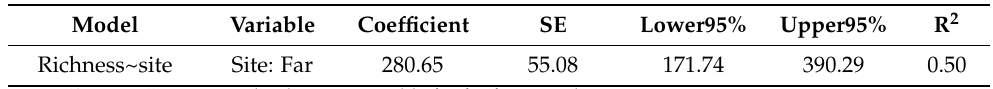
Table 1. Summary of generalized linear model results for examining the difference in wildlife richness at sites of bridge and culvert and sites for control at sites far from roads. Model